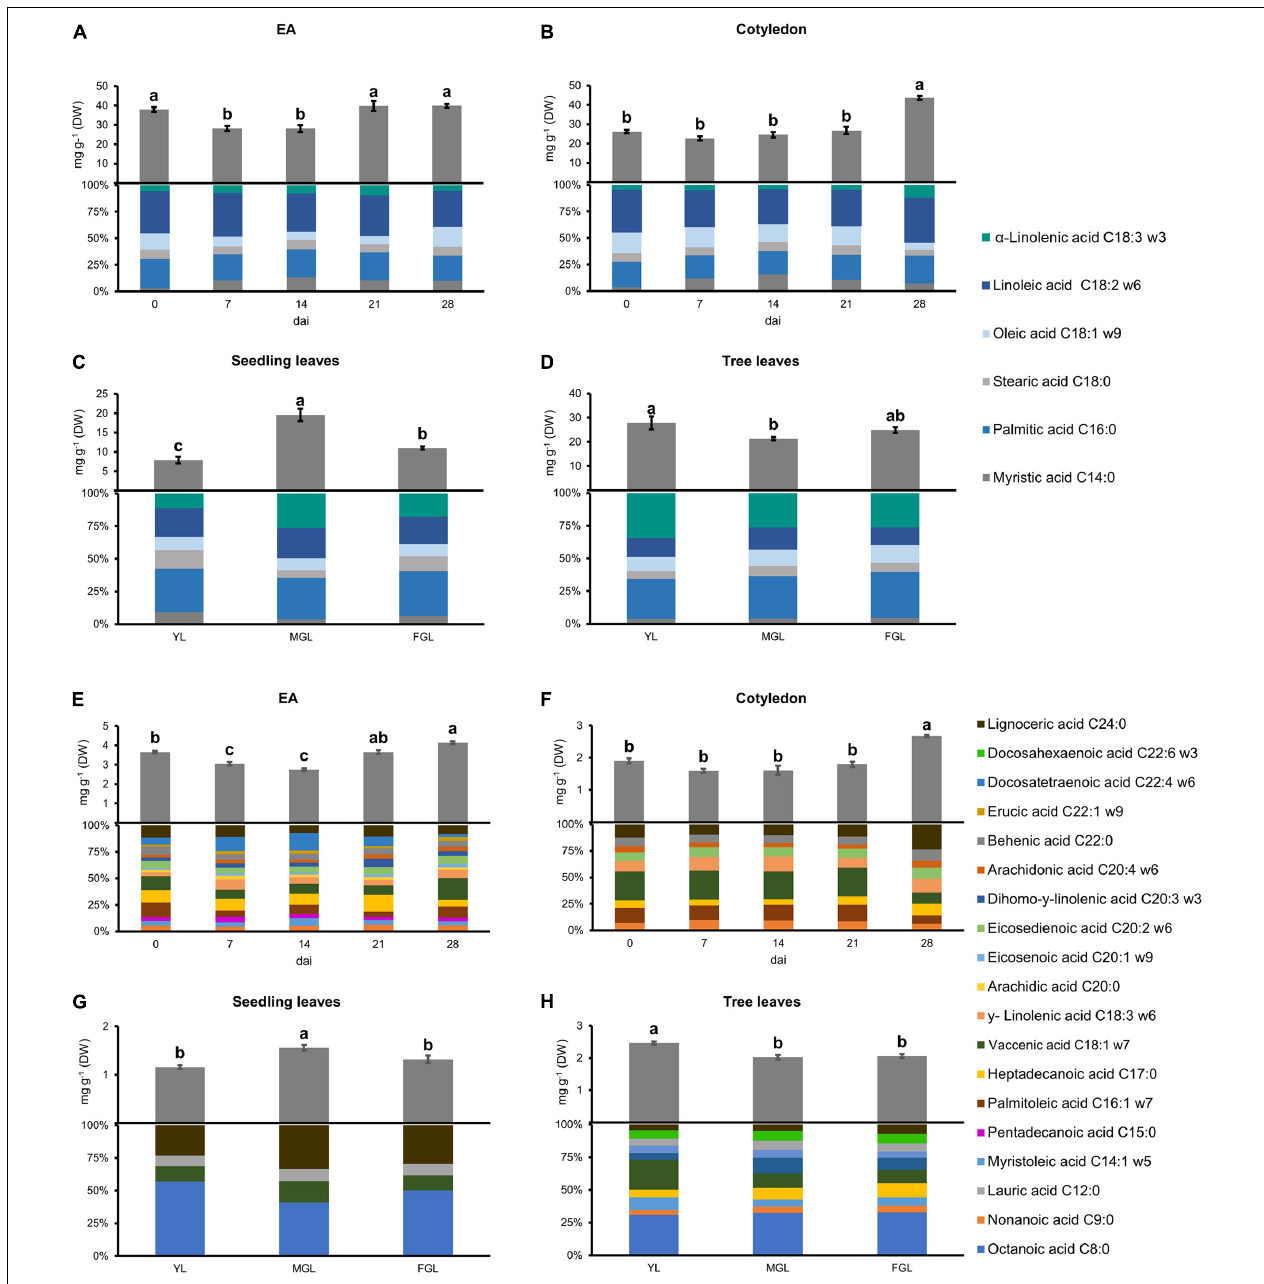
FIGURE 2 | Major and minor FA content and composition in different avocado tissues. (A,E) EA. (B,F) COT. (C,G) SDL leaves. (D,H) TRL. Error bars represent SE, Different letters indicate statistical differences between treatments (ANOVA, Fisher LSD, P < 0.05). n = 4 for EA and Cotyledon; n = 3 for leaves. EA embryonic